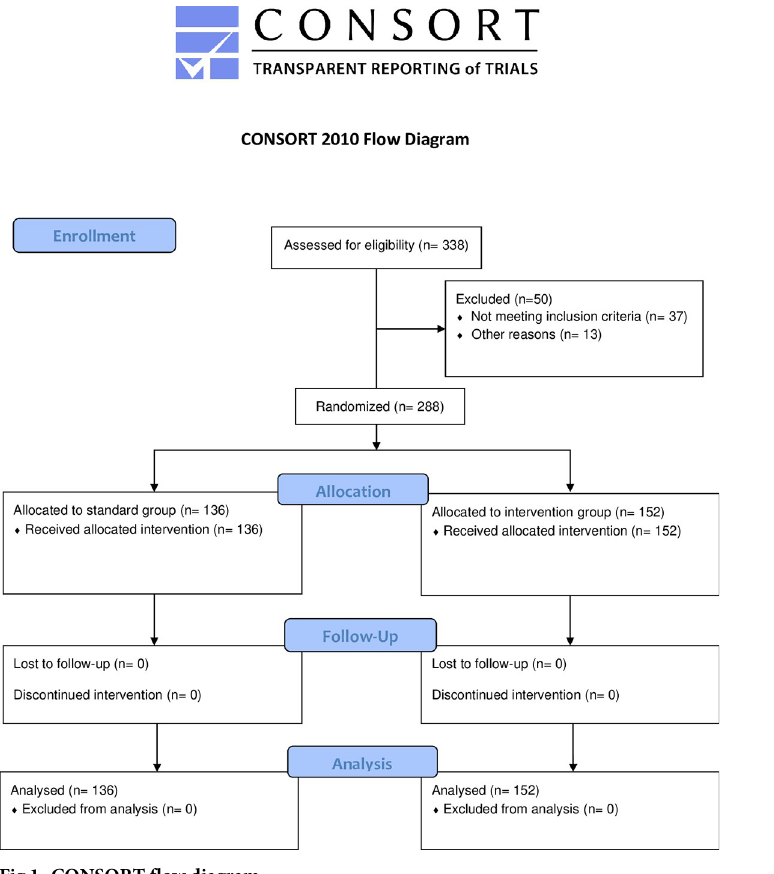
Fig 1. CONSORT flow